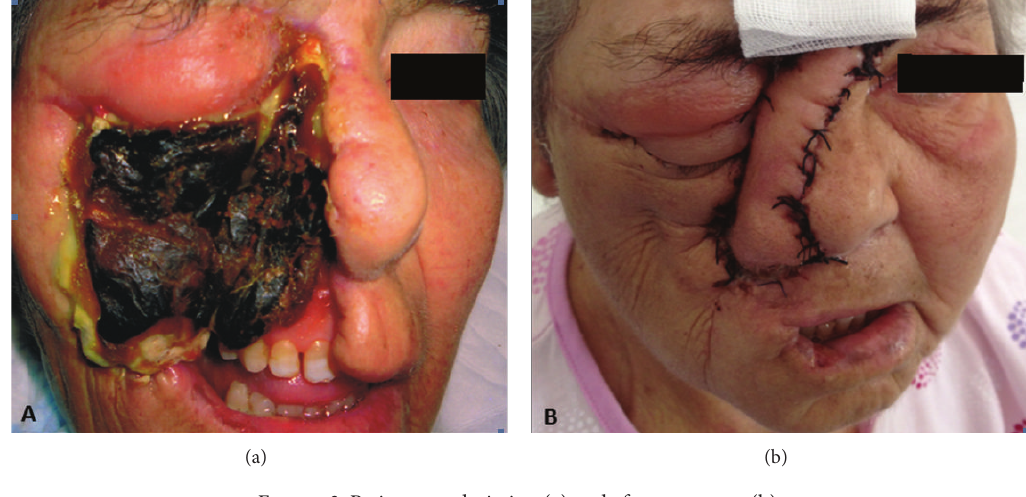
Figure 3: Patient on admission (a) and after treatment